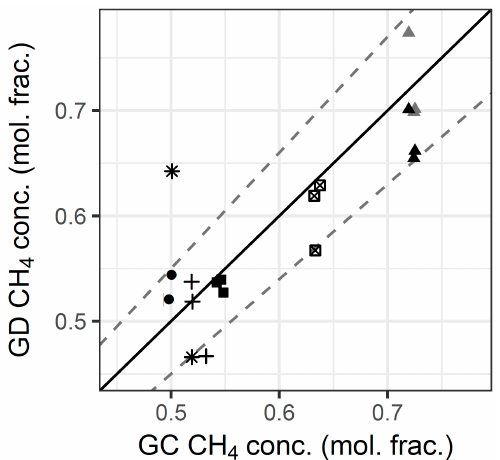
Figure 3. Comparison of complete total gas density (GD t ) and gas chromatography (GC) estimates of biogas CH 4 content for Experiment 1A. Values are volume-weighted average values for the entire incubation. Each substrate is shown with a unique plotting symbol (triangles for ethanol, asterisks for inoculum-only, filled squares for FI1). For ethanol, gray symbols show results including initial headspace correction. Dashed lines show ± 10%.